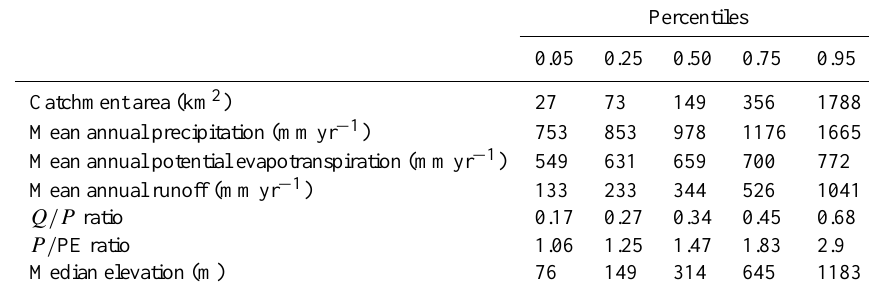
Table 1. Characteristics of the 907 catchments. P – precipitation, PE – potential evapotranspiration, Q – discharge.